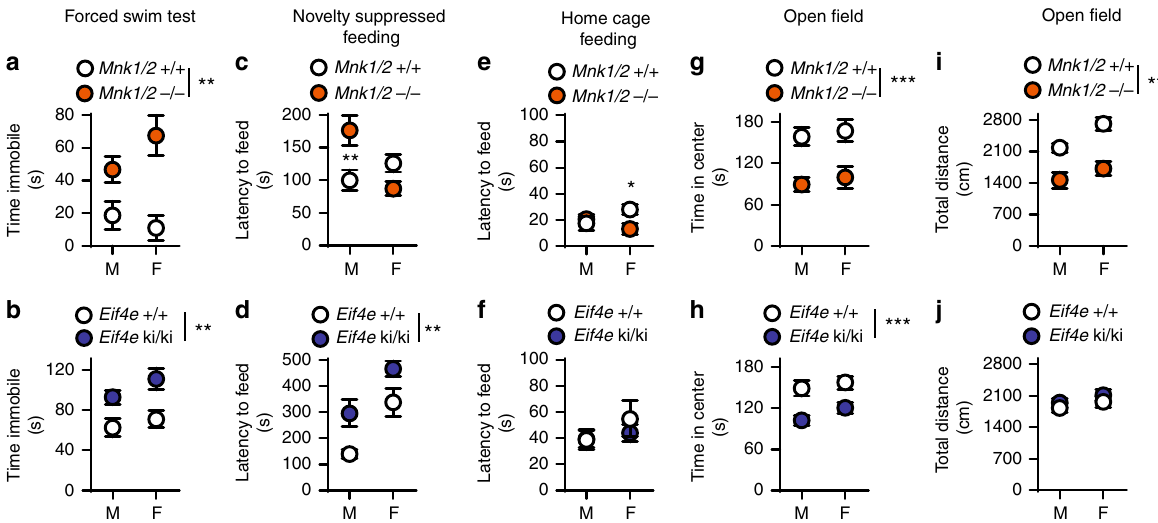
Fig. 1 Genetic inhibition of eIF4E phosphorylation induced anxiety- and depression-like behaviors. a Male (M) and female (F) mice mutant for the genes encoding MNK1 and MNK2 ( Mnk1/2 − / − mice) and their wild-type littermates ( Mnk1/2 + / + ) were assessed for despair-like behavior in the forced swim test (FST) (M, n = 8 Mnk1/2 + / + , n = 9 Mnk1/2 − / − ; F, n = 3 Mnk1/2 + / + , n = 9 Mnk1/2 − / − ). b Male and female mice bearing a mutation in the Eif4e gene (Ser209 was substituted to Ala, Eif4e ki/ki) were also tested in the FST (M, n = 19 Eif4e + / + , n = 19 Eif4e ki/ki; F, n = 7 Eif4e + / + , n = 8 Eif4e ki/ki). c Novelty suppressed feeding (NSF) was assessed in Mnk1 /2 − / − (M, n = 9; F, n = 10) and wild-type mice (M, n = 8; F, n = 10). d NSF was also assayed in Eif4e + / + and ki/ki mice (M, n = 9 Eif4e + / + , n = 9 Eif4e ki/ki; F, n = 8 Eif4e + / + , n = 9 Eif4e ki/ki). e Latency to feed in the home cage (home cage feeding, HCF) was determined in the Mnk1/2 − / − and f Eif4e ki/ki mice and their littermates. g Time spent in the center of an open fi eld (OF) arena was measured in Mnk1/2 − / − (M, n = 12 Mnk1/2 + / + , n = 8 Mnk1/2 − / − ; F, n = 7 Mnk1/2 + / + , n = 13 Mnk1/2 − / − ) and h Eif4e ki/ki mice and their littermates (M, n = 17 Eif4e + / + , n = 18 Eif4e ki/ki; F, n = 11 Eif4e + / + , n = 19 Eif4e ki/ki). i Locomotion was also measured in Mnk1/2 − / − and j Eif4e ki/ki mice. ** p < 0.01, *** p < 0.001 vs. wild-type littermates (see Supplementary Table 2 for detailed results of statistical